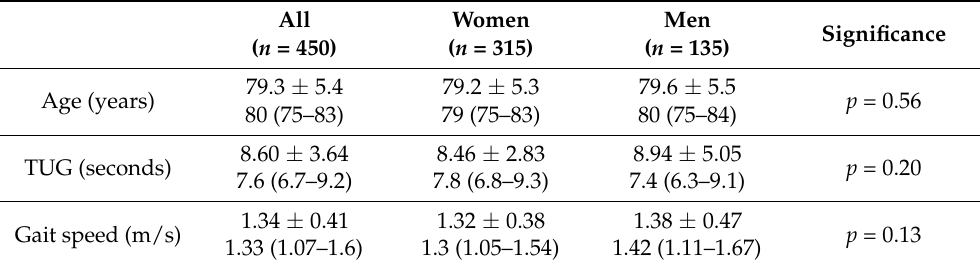
Table 1. Age, Timed Up and Go and gait speed in studied women and men. All